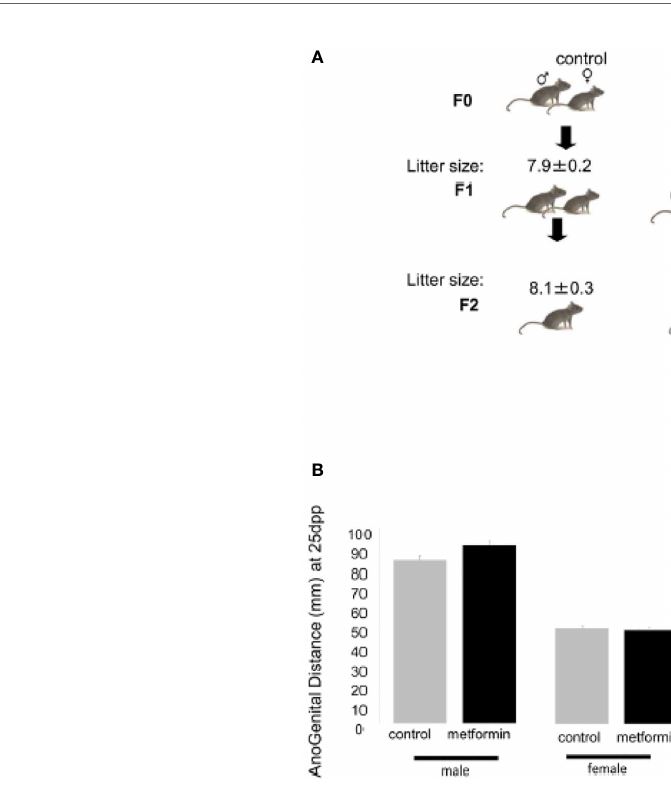
FIGURE 5 | Effect on in utero metformin exposure on the fertility of adult male offspring. (A) Number of pups per litter from the F0 crossing and F1 crossing (n=8 litters per cross). Values of litter size are expressed as mean ± SEM. (B) Anogenital Distance (mm) of male and female mice exposed to metformin in utero at